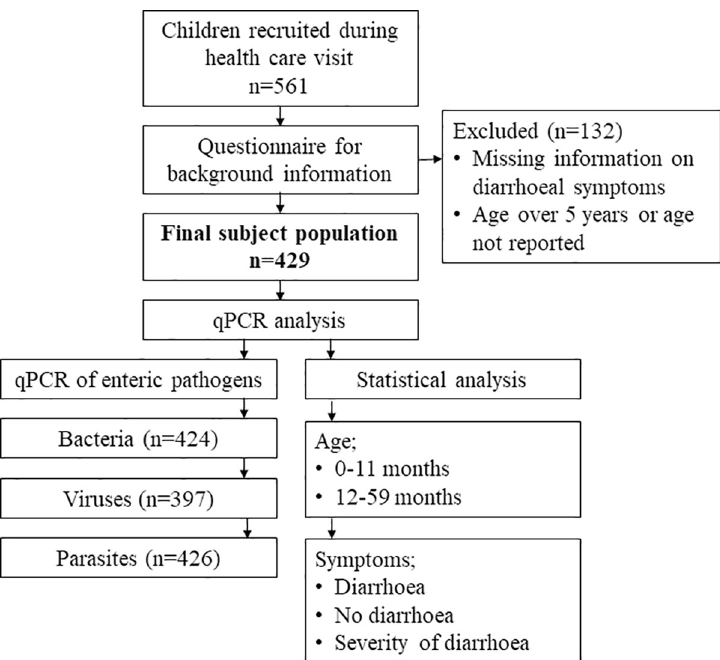
Fig 1. Study protocol. A total of 561 children were recruited into the study. Samples of children over five years of age or those with no information about age or diarrhoea were not included in the